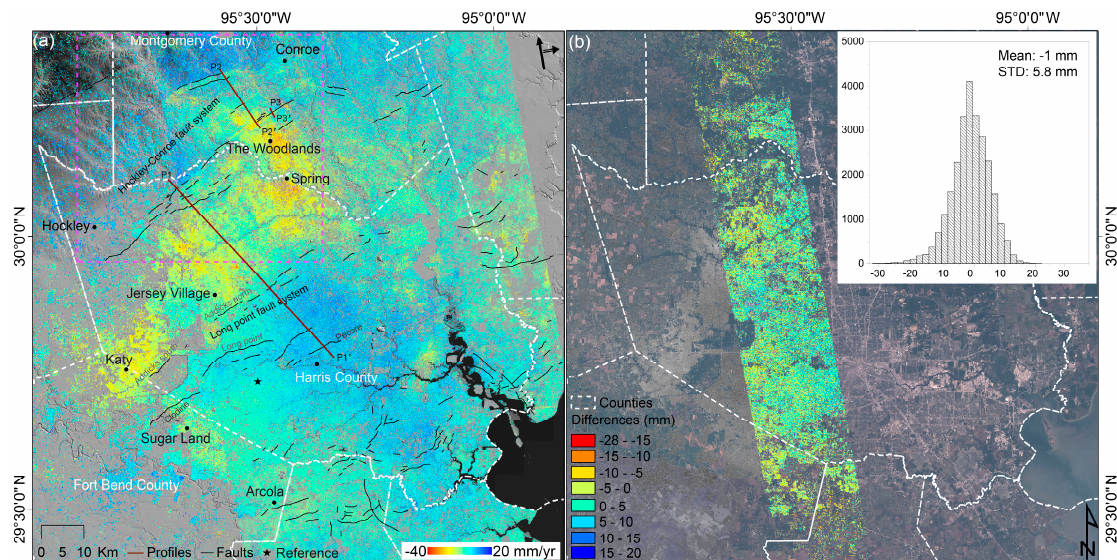
Figure 3. ( a ) Annual line-of-sight (LOS) deformation map derived from ALOS datasets, which shows a mosaic of two ALOS tracks 175 and 176. The negative values represent ground surface movement away from the satellite. The pink box in ( a ) indicates our main study area used for the discussion of InSAR results in Figure 5; the dark red lines are profiles across the active faults (labeled as P#P#’). ( b )Vertical displacement difference derived from path 175 and 176 by assuming the observed InSAR deformation is vertical; the corresponding statistical histogram of ( b ) is an inset on the upper-right corner.